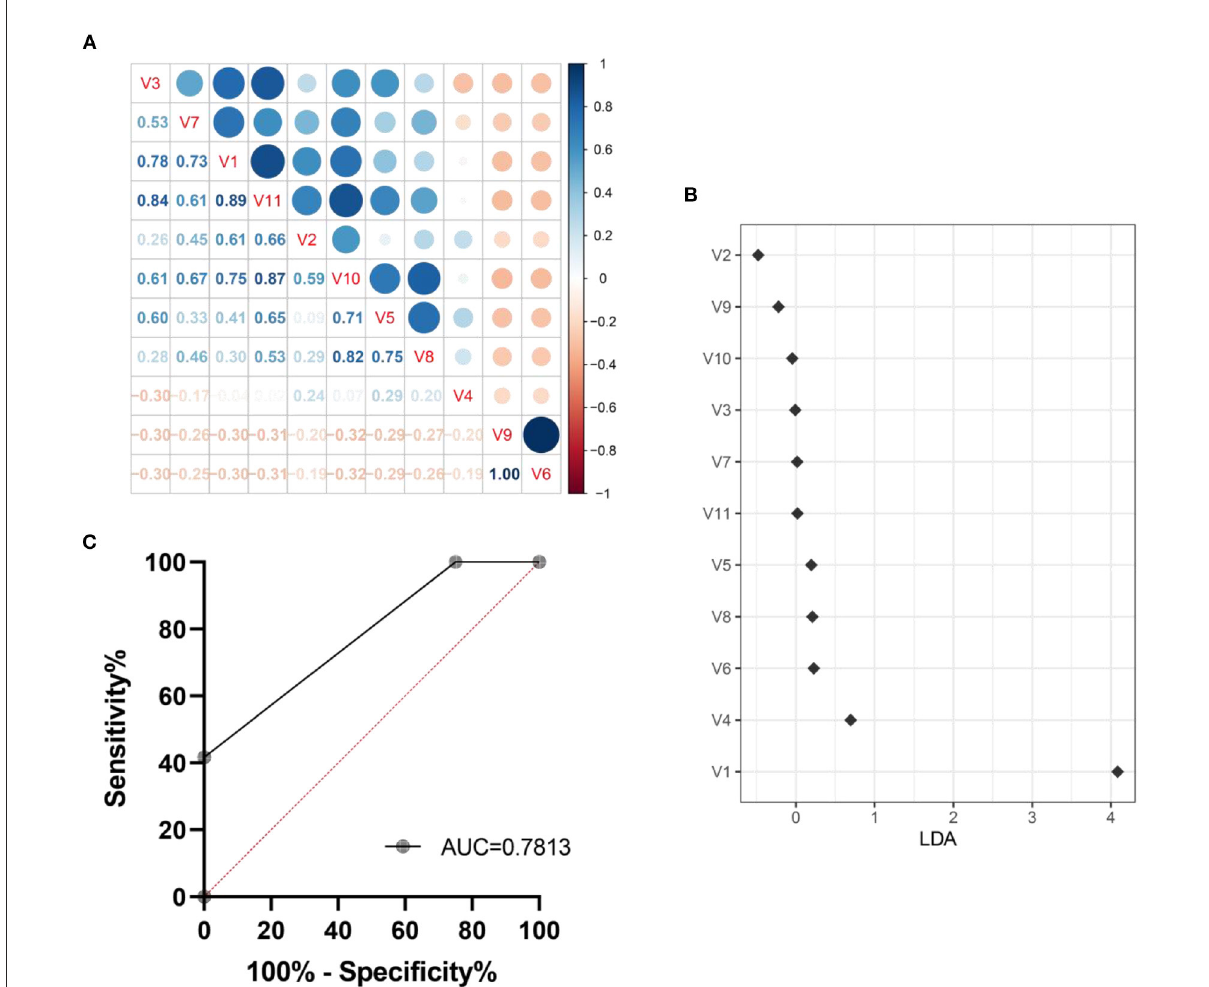
FIGURE8 Machine learning model for intestinal aging was constructed and verified based on the significantly different genera in high salt (HS) induced mice. The correlation coefficient among genra are shown in here (A) . The LDA linear judgment analysis (B) . Evaluation of diagnostic ability based on ROC training set verification (C) . V1-V11: unclassified_f__Lachnospiraceae , Desulfovibrio , Lachnospiraceae_UCG-006 , norank_f__Lachnospiraceae , Escherichia-Shigella , Eubacterium_siraeum_group , NK4A214_group , Butyricicoccus , Anaerofustis